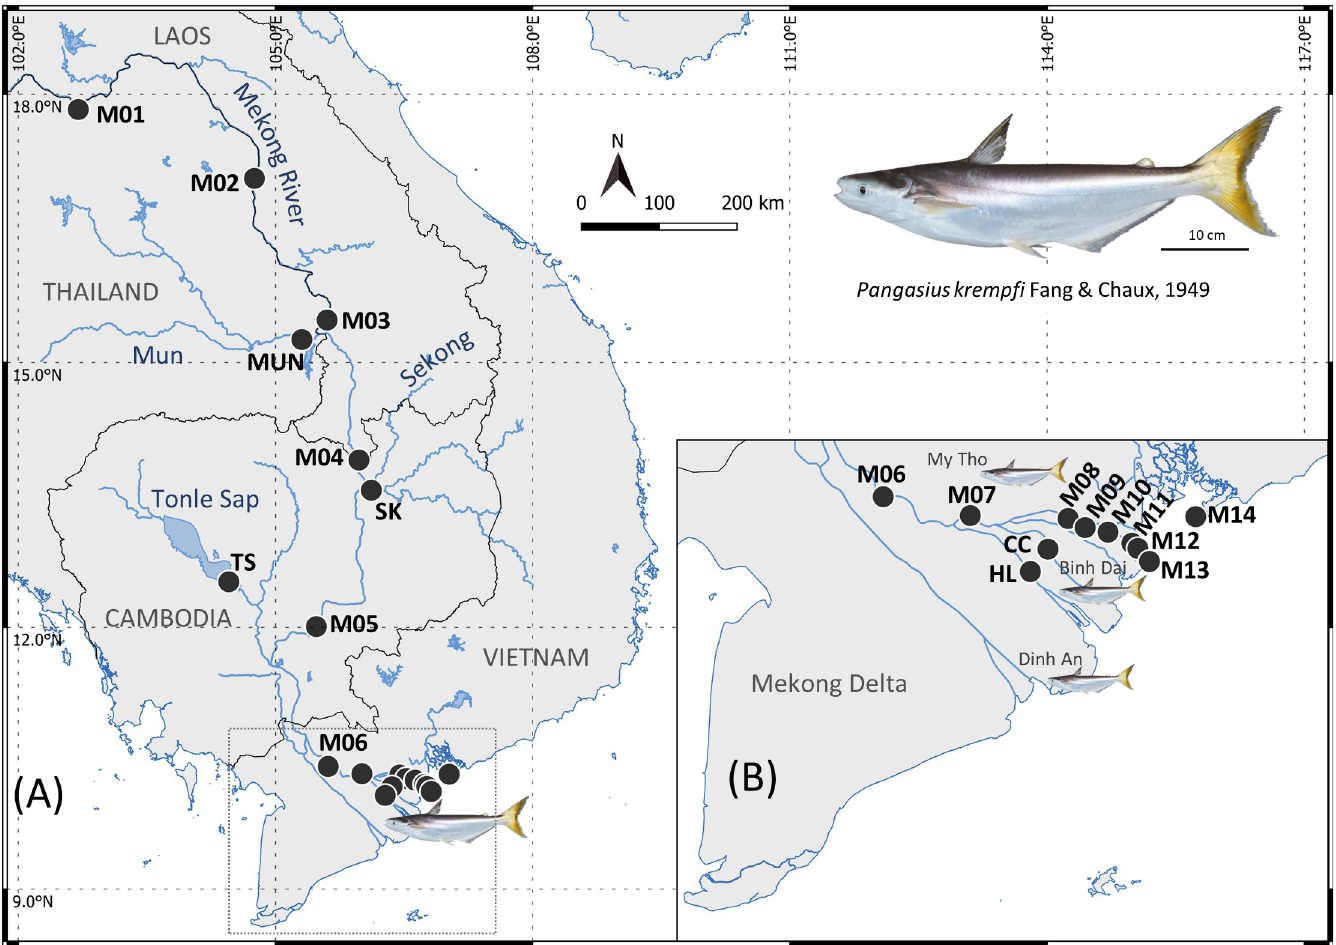
Fig 1. Sampling sites along the Mekong River. (A) Map of sampling sites for water (black circle) and fish (catfish) along the Mekong River, and (B) detailed map of the sites in the Mekong Delta.